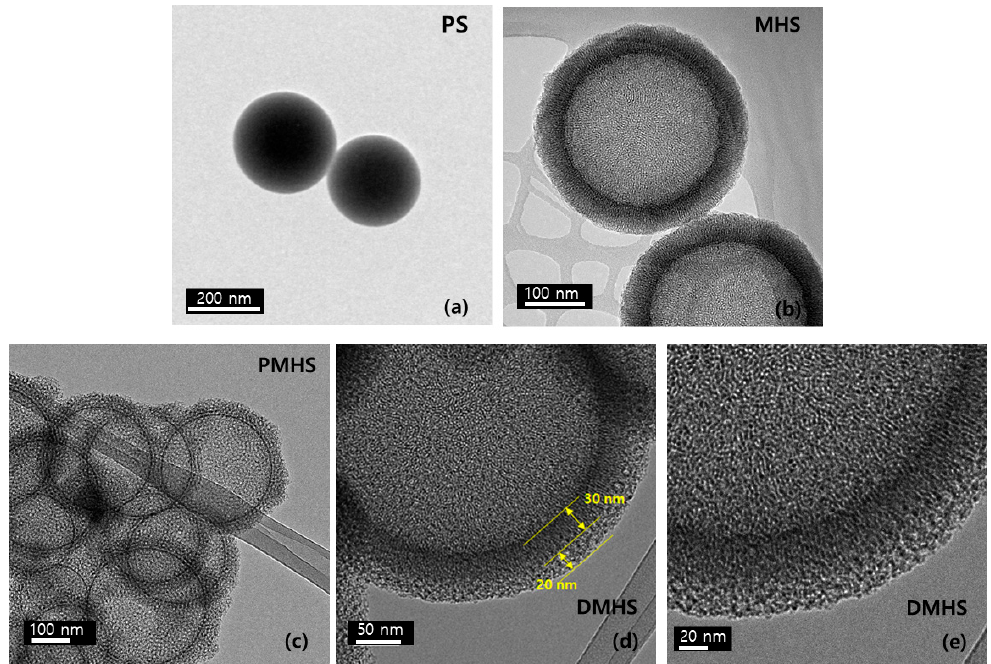
Figure 1. TEM images of the ( a ) PS, ( b ) MHS, ( c ) PHMS, and ( d , e ) DMHS.